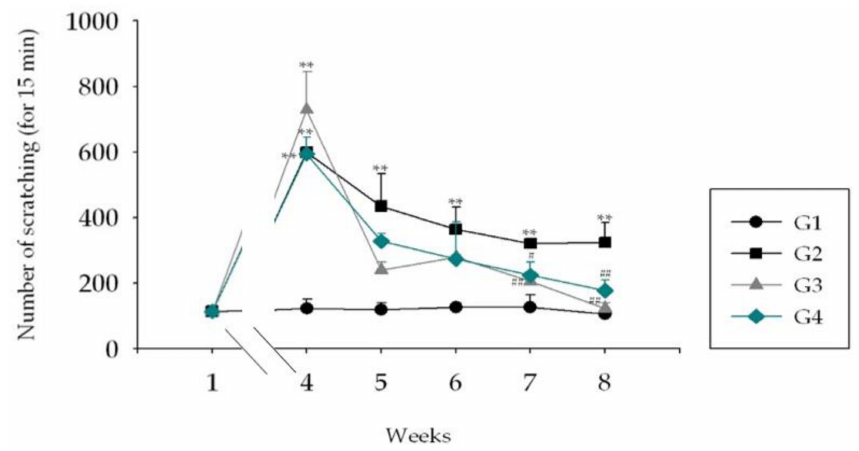
Figure 8. Scratching behavior in NC / Nga mice. G1: negative control group; G2: positive control group (HDM only); G3: drug control (0.1% Hc); G4: 1% ASex. All groups were induced with HDM except for G1. The results are expressed as the mean ± SD of triplicate experiments ( n = 3). Statistical significance was assessed by ANOVA: * p < 0.05, ** p < 0.01 compared with G1. # p < 0.05, ## p < 0.01 compared with G2.